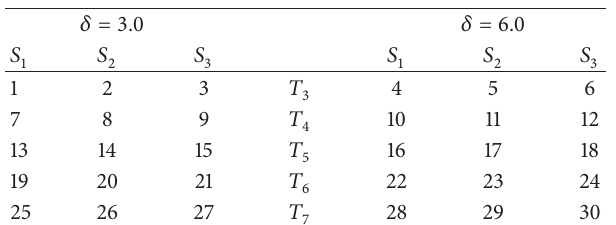
Table 5: Types of